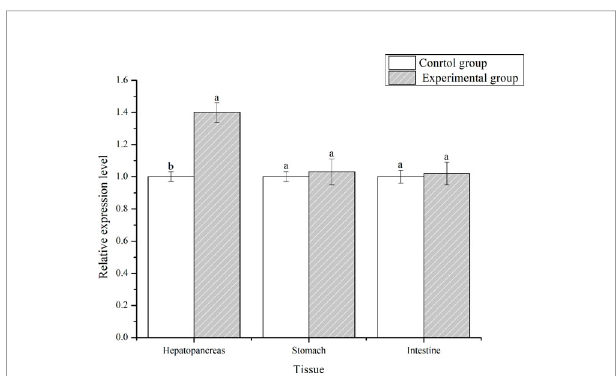
FIGURE 4 | Tissues distribution analysis of LvFABP mRNA after VP AHPND challenge. Shrimp tissues (intestine, stomach, and hepatopancreas) were collected after infection with the VP AHPND strain VP-E1 at 48 h. Each bar represents the mean ± standard deviation (SD) of triplicate experiments. Different letters indicated signi fi cantly difference (P < 0.05).